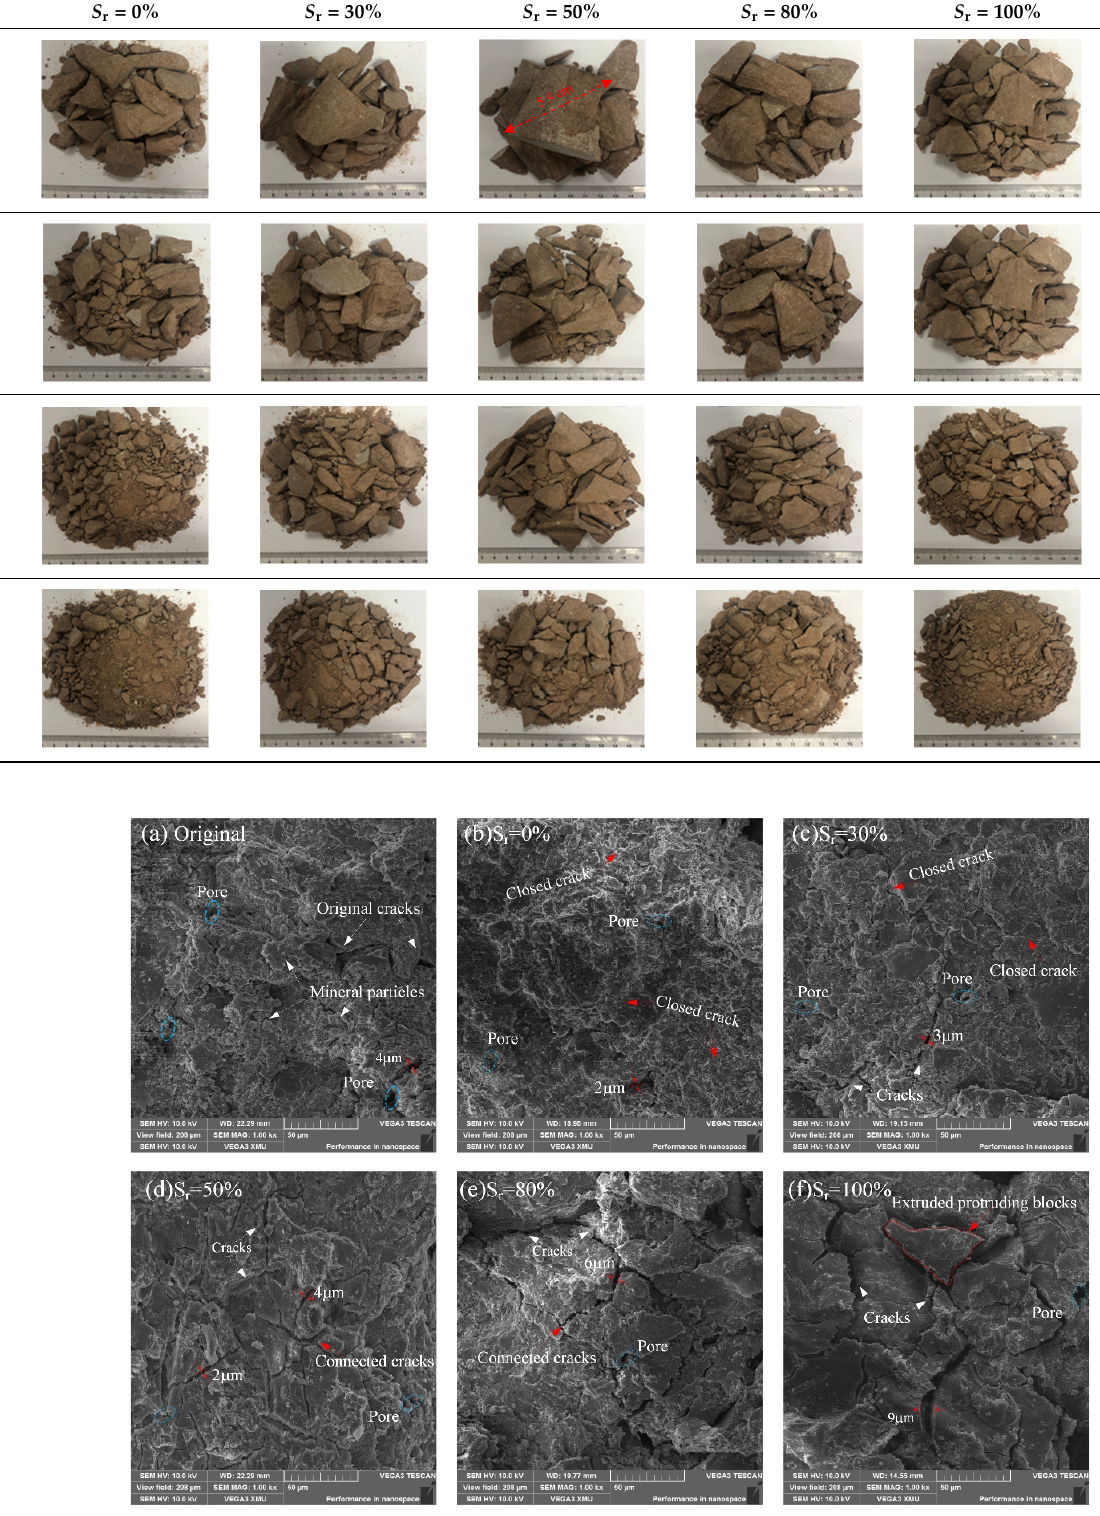
Figure 17. Microscopic characteristics of frozen sandstone sample with different saturation from SEM images (1000×).